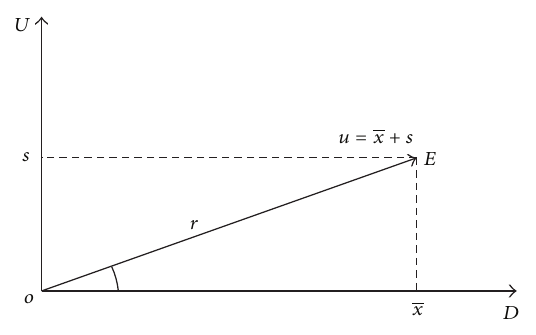
Figure 1: Determinacy-uncertainty